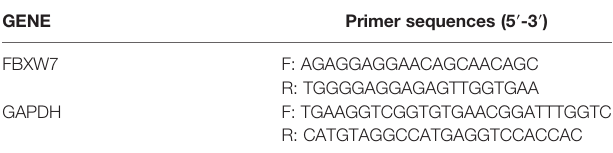
TABLE 1 | Indicated primers used in PCR